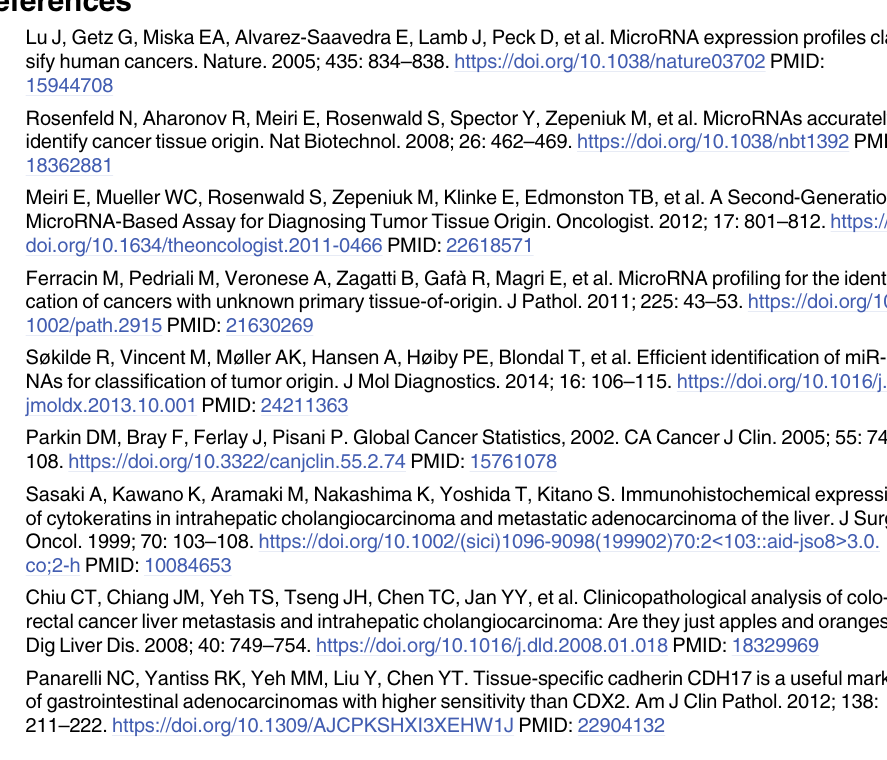
S2 Table. Discriminatory microRNA differentially expressed between two branches of each node of the decision tree, at feature selection p < 0.00005. S3 Table. TCGA small RNA sequencing data were downloaded from the Genomic Data Commons Data Portal (GDC,